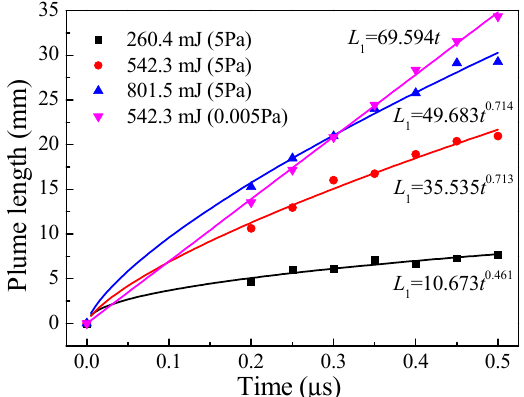
Figure 20. The plume length of first stage variation with time and its fitting curve at different energies (ambient pressure 5 Pa and 26.5% Al).